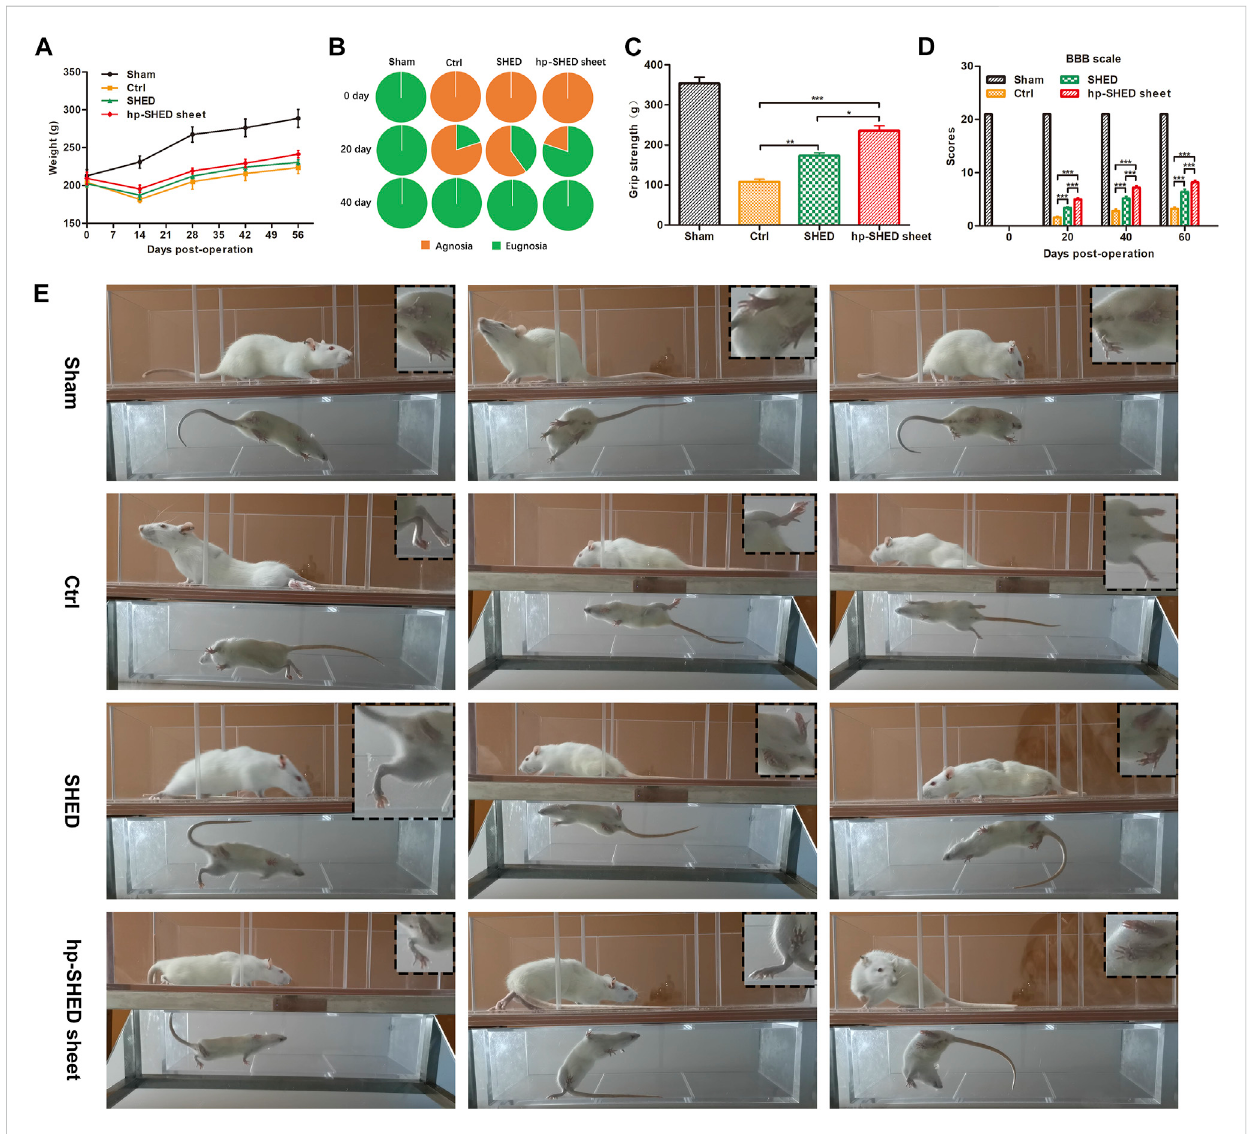
FIGURE 2 Hp-SHED sheet was more active than SHED to recover the sensory and motor in complete SCI rats. (A) The weight change in SCI rat model with indicatedtreatments. (B) Thepercentageofsensoryrestorativeratsatdays0,20,and40post-treatment. (C) Gripstrengthofeachgroupat60